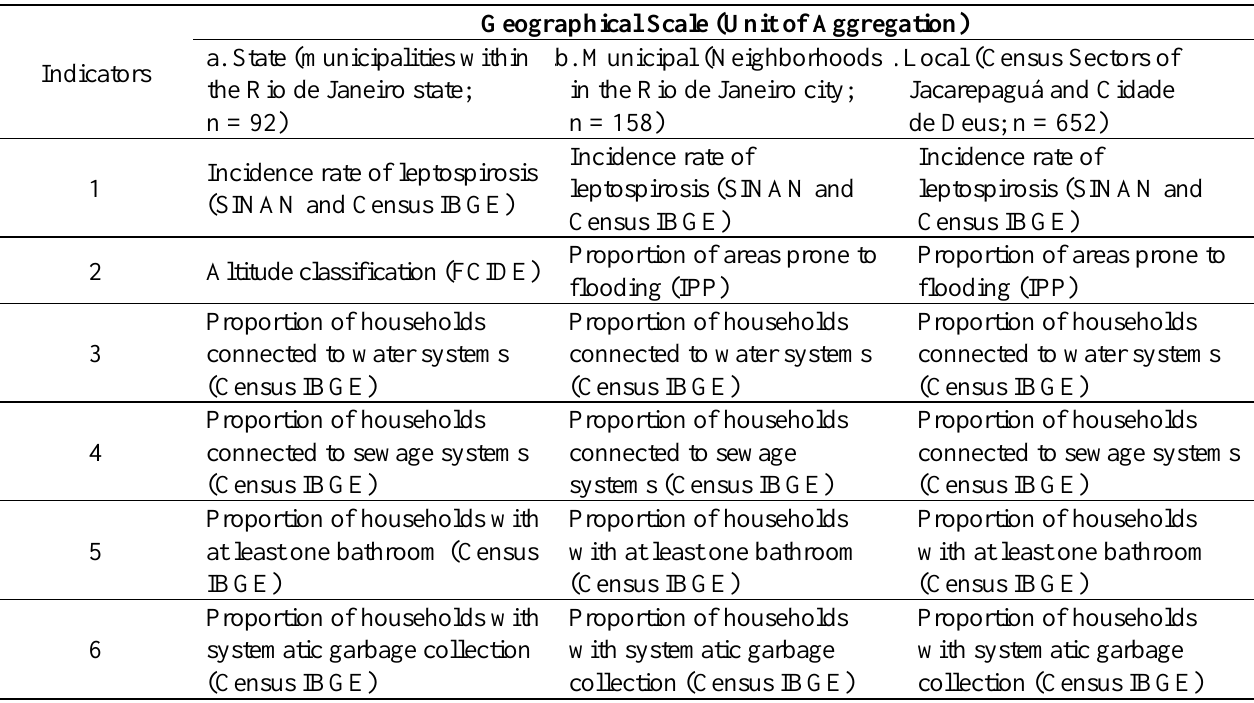
Table 1. Socioeconomic and environmental indicators at three geographical scales and their respective units of